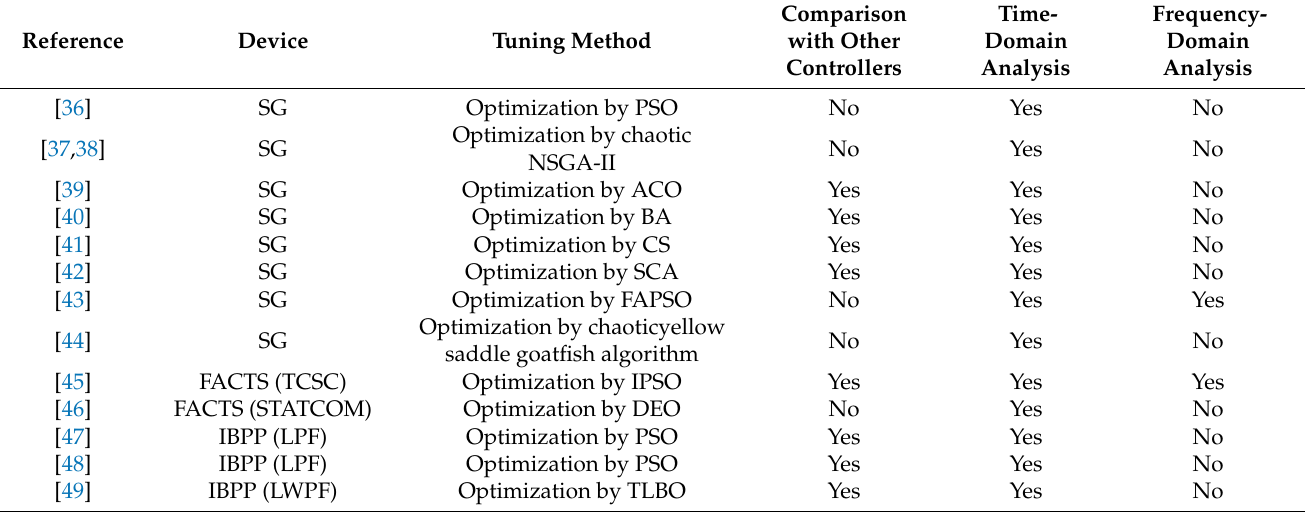
Table 2. Summary of the FOPID controller for LFO mitigation in power systems.